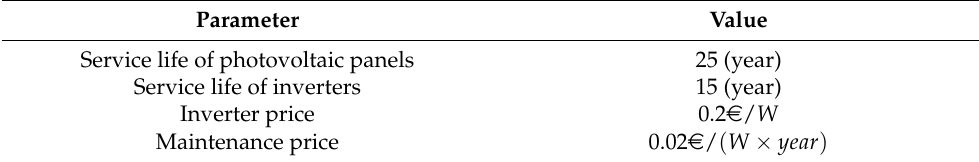
Table 2. Economic factors used in investment cost calculations.